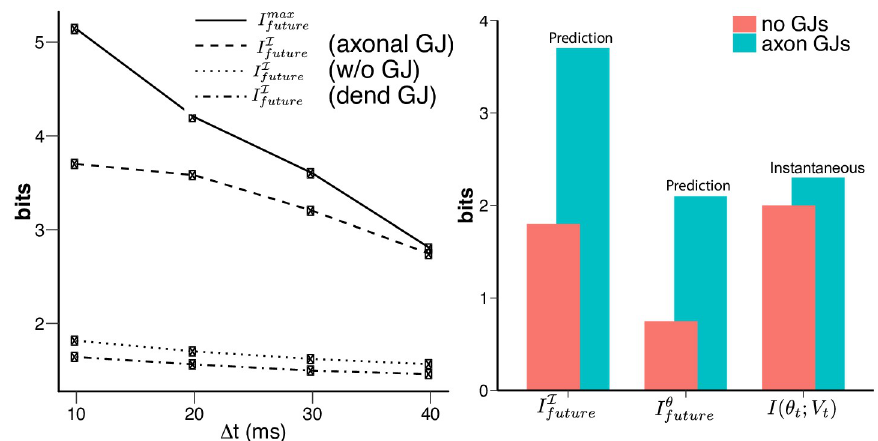
Fig 2. The capacity of the VS network to encode predictive information varies with the anatomical locations of the gap junction between VS cells. A) The predictive information about the future input current, I future encoded in four different schemes: 1) the past dendritic input current (solid line, this is the limit I max . It is also the upper bound of future I future ), 2) the past axonal voltage when the gap junctions are present between VS axons (dashed line), 3) when the gap junctions are present between VS dendrites (dotted line) and 4) in the absent of gap junctions (dash-dotted line). All gap junctions = 1000 nS for both settings when they are present. Only their locations differ, i.e. axon vs. dendrite. Note that when the gap junctions are present between VS cell axons, the output voltages preserve almost the entire amount of the predictive information available at the inputs (red). (See also Materials and methods.) Such encoding is not because of linear correlation. As shown in, there is negligible linear correlation between the past and future egorotation at Δ t = 30 ms or Δ t = 40 ms . B) The presence of axonal GJs improves the encoding of predictive information more than instantaneous input. We compare how the VS network encodes the predictive information in two scenarios (i.e. I future and I future ( θ , Δ t ) with Δ t = 10 ms) and the instantaneous egomotion θ with axonal GJs (cyan bars) and without GJs (red ; V ) (without prediction forward in time) is compiled bars). The encoding of instantaneous constant egomotion I ( θ t t from the previous work [46]. I ( θ t ; V t ) was defined as the mutual information between a constant rotation θ and the transient axonal voltages of the VS network (integrated for Δ t = 10